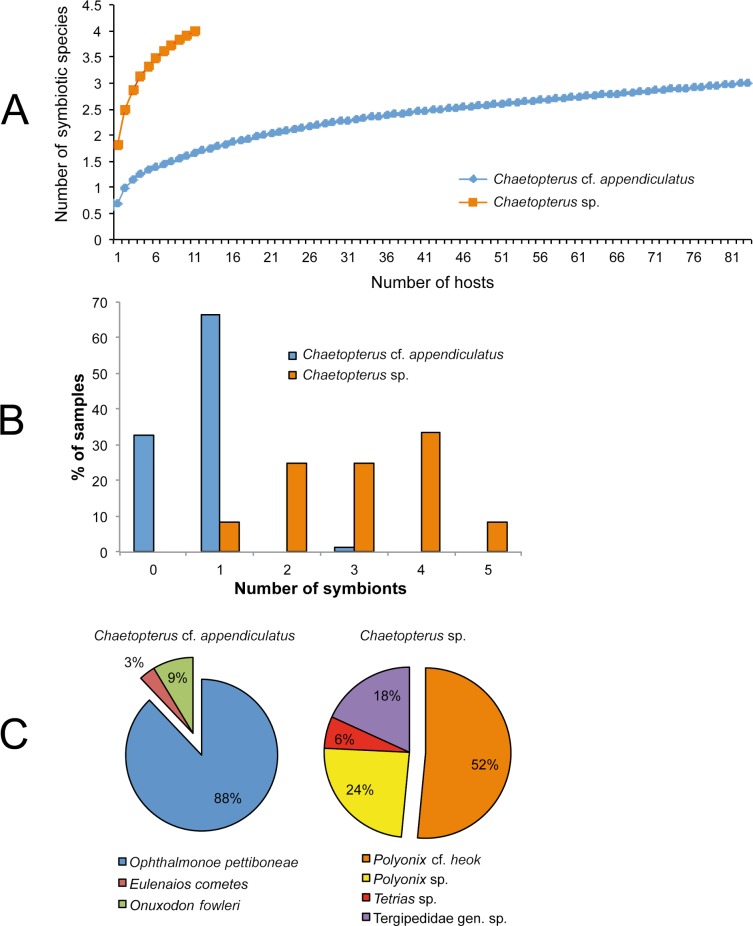
Characterization of the symbiotic communities associated with the two host species of Chaetopterus: (A) rarefaction curve; (B) distribution of symbionts per host; (C) relative abundance of the symbiotic species.